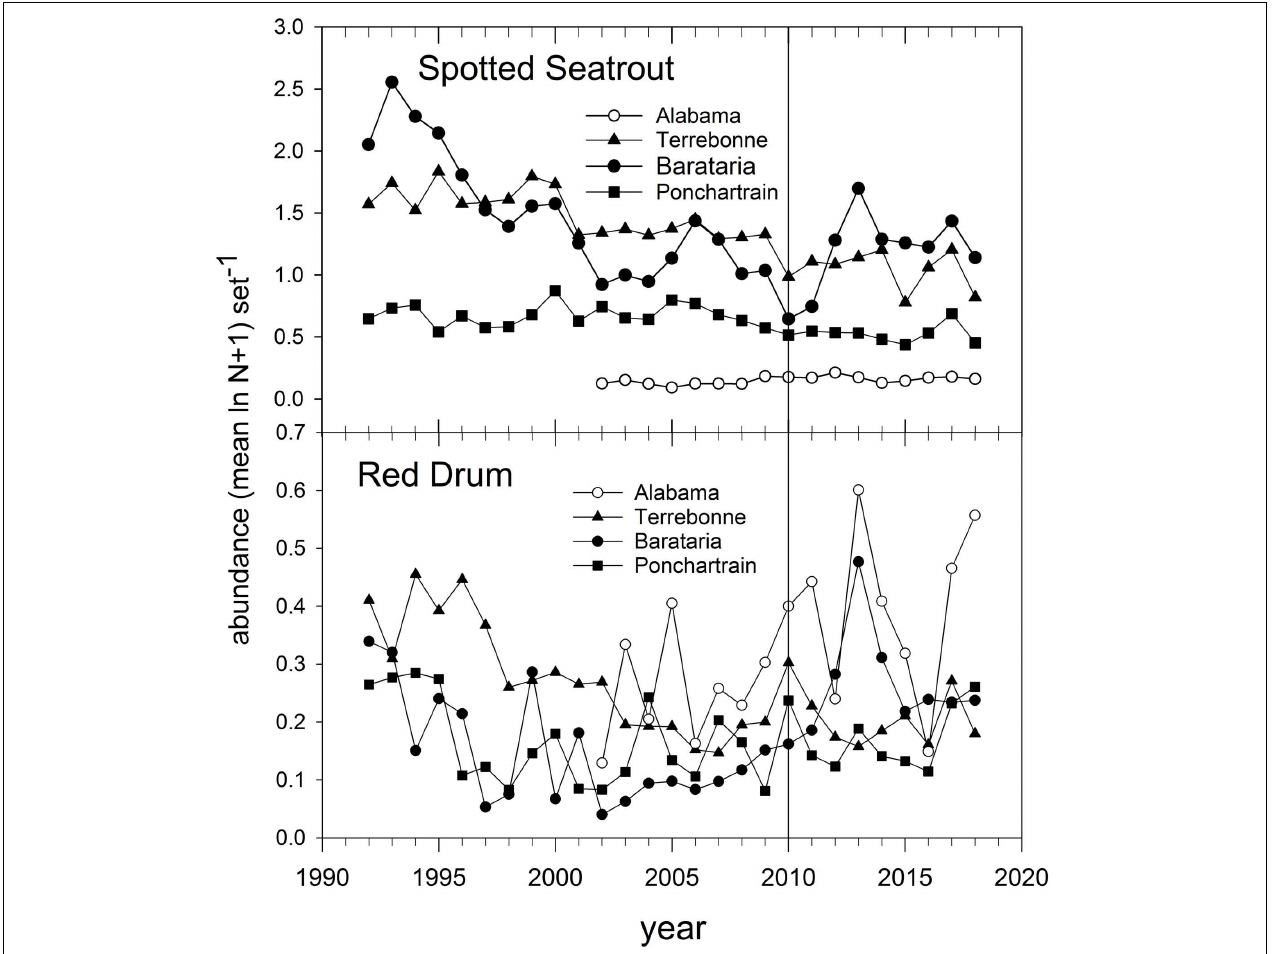
FIGURE 14 | Annual relative abundance of Spotted Seatrout and Red Drum in fishery-independent gill net surveys off Alabama and in three Louisiana basins. Data are from the Alabama Marine Resources Department and the Louisiana Department of Wildlife and Fisheries gill net sampling